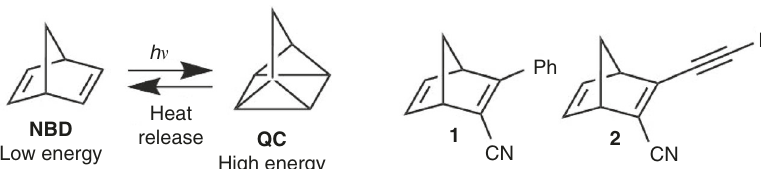
Fig. 1 Molecular system. The norbornadiene ( NBD ) – quadricyclane ( QC ) couple and the previously reported monomeric norbornadienes 1 and 2